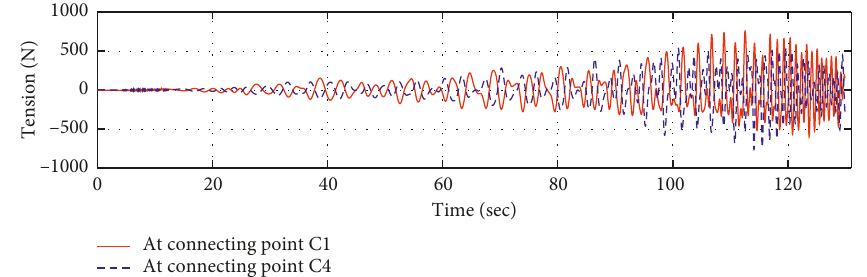
Figure 28: Comparison of the transverse force of the traction system at the connecting points.